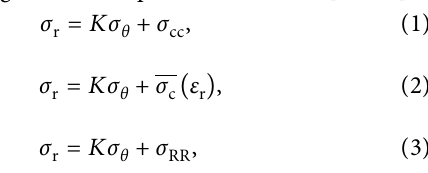
Figure 3: Computational mechanical model of EPSFM (note: ε A and ε B are, respectively, the maximum and minimum principal strains at “B” point). “A” point; ε B 12 32